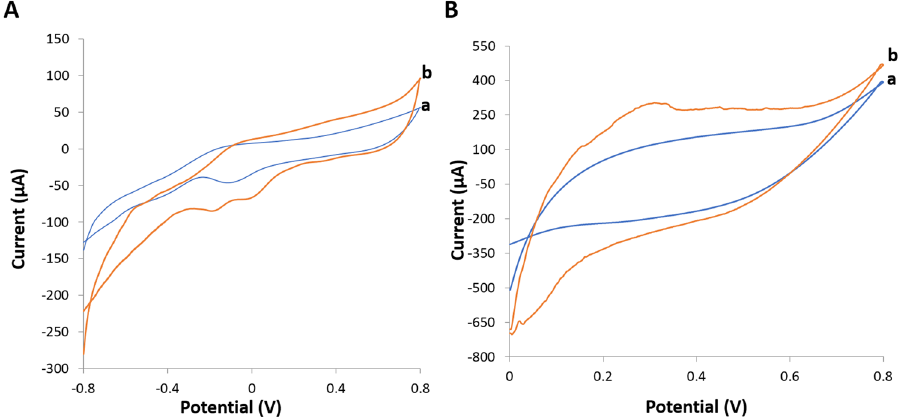
Figure 2. Cyclic voltammogram of the bioelectrodes. ( A ) Bioanode in the absence of glucose (a) and presence of 5 mM glucose (b). ( B ) Biocathode in 100 mM phosphate buffer saturated with air (a) and in the presence of O 2 (b). All CVs were performed at 37 °C and pH 7.4.